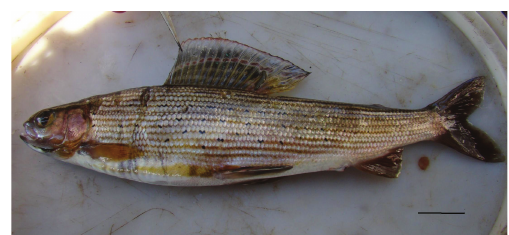
Figure 2: Localization of the acanthobdella parasite on the dorsal fin of Lena grayling ( T. arcticus baicalensis ). Bar is equal to 2.5